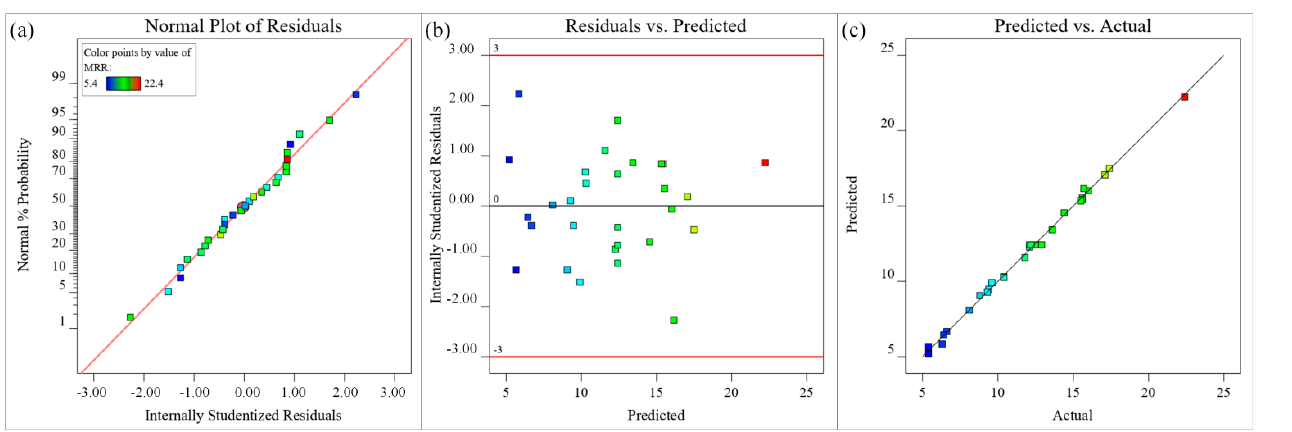
The different-colored sample points in Figure 13 represent the MRR under different process parameters. The normal probability of residuals of all sample points in Figure 13a is approximately a straight-line distribution, indicating that the residuals are normally distributed, and the MRR model has good adaptability. The upper and lower lines in Figure 13b represent the distribution range of residuals. The residuals of all predicted MRR are randomly distributed around the zero axis within the distribution range, which indicates that there is no obvious pattern between the residuals of MRR. Most of the data points in Figure 13c are distributed on the straight line (y = x), and a small part of the data points are distributed around the straight line (y = x), indicating that the experimental value of the MRR is in good agreement with the predicted value, and the model fitting accuracy is higher. In summary, the constructed approximate mathematical model for the MRR of titanium alloy microgrooves processed by a waterjet-guided laser has high adaptability and accuracy.